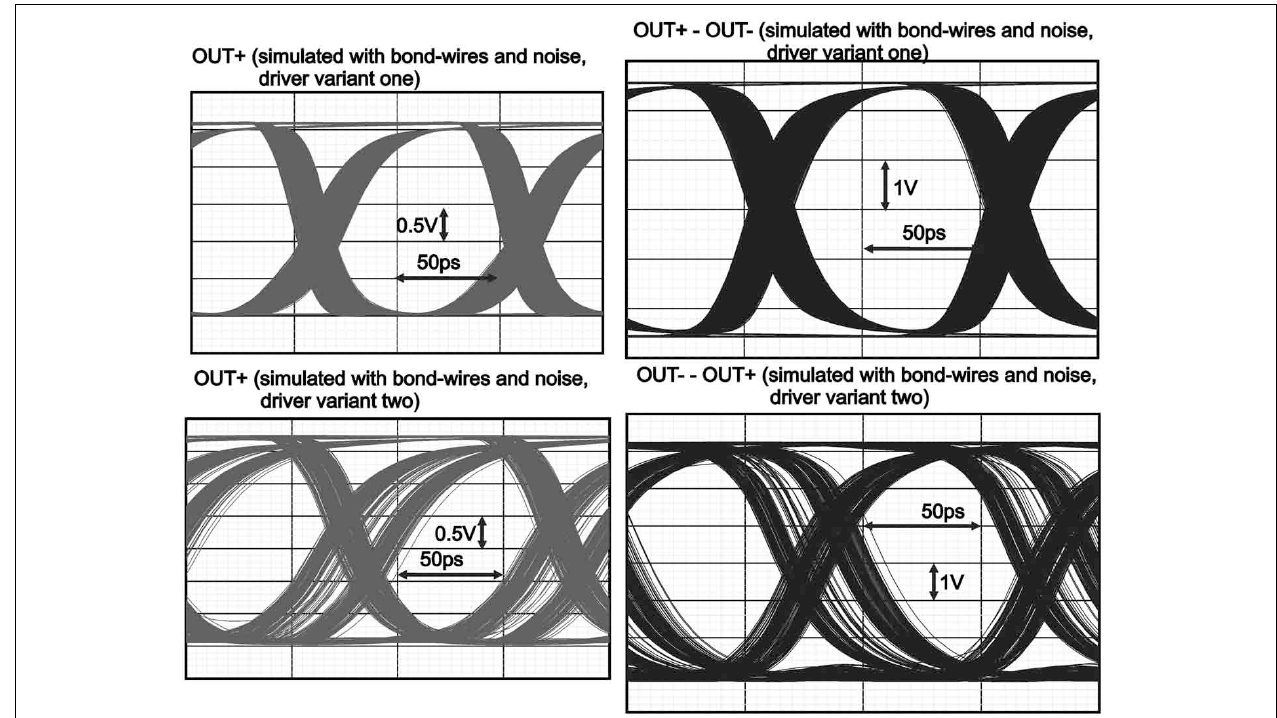
FIGURE 9 | Simulated eye diagrams for driver variant one (top) and driver variant two (bottom) for 50mV pp differential input voltage at 10Gb/s including the influence of bond-wires and noise. The eye diagram of driver variant two is degraded by a not optimized capacitor C 4 = 2pF (see Figure 4 ).